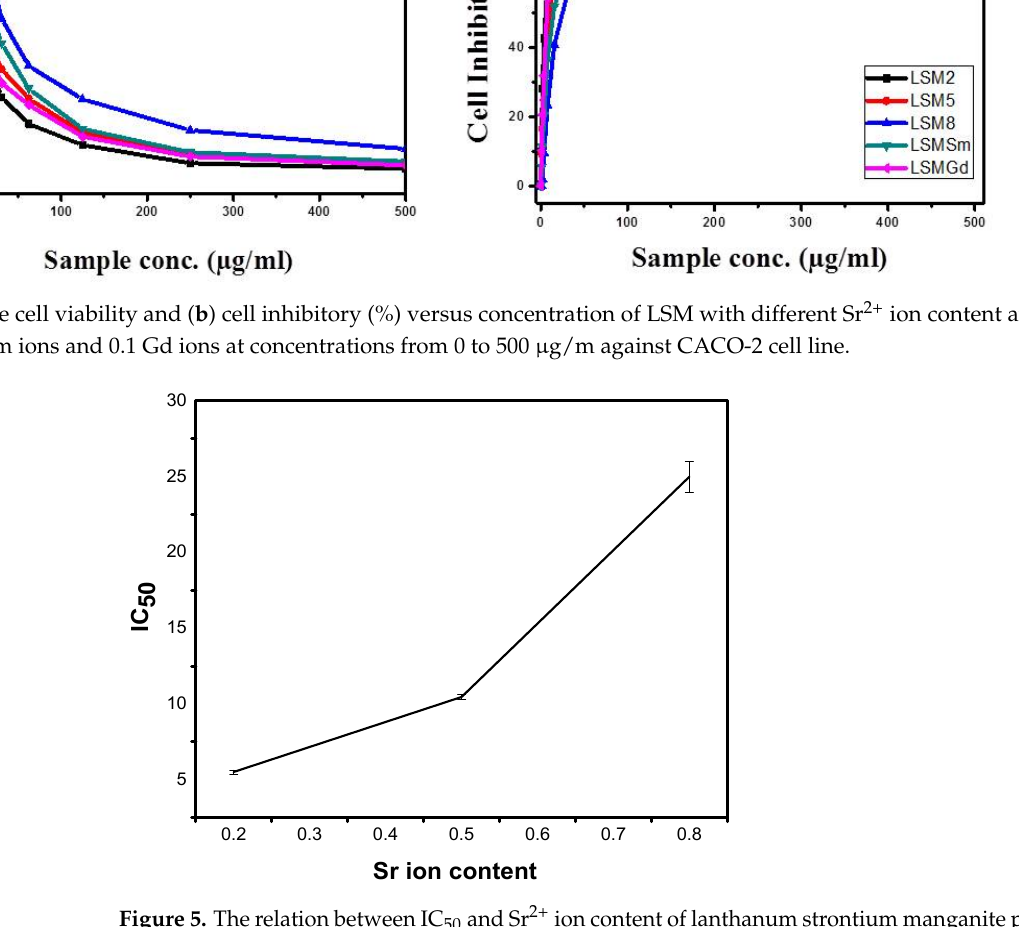
Figure 5. The relation between IC 50 and Sr 2+ ion content of lanthanum strontium manganite prepared by citrate precursor method.